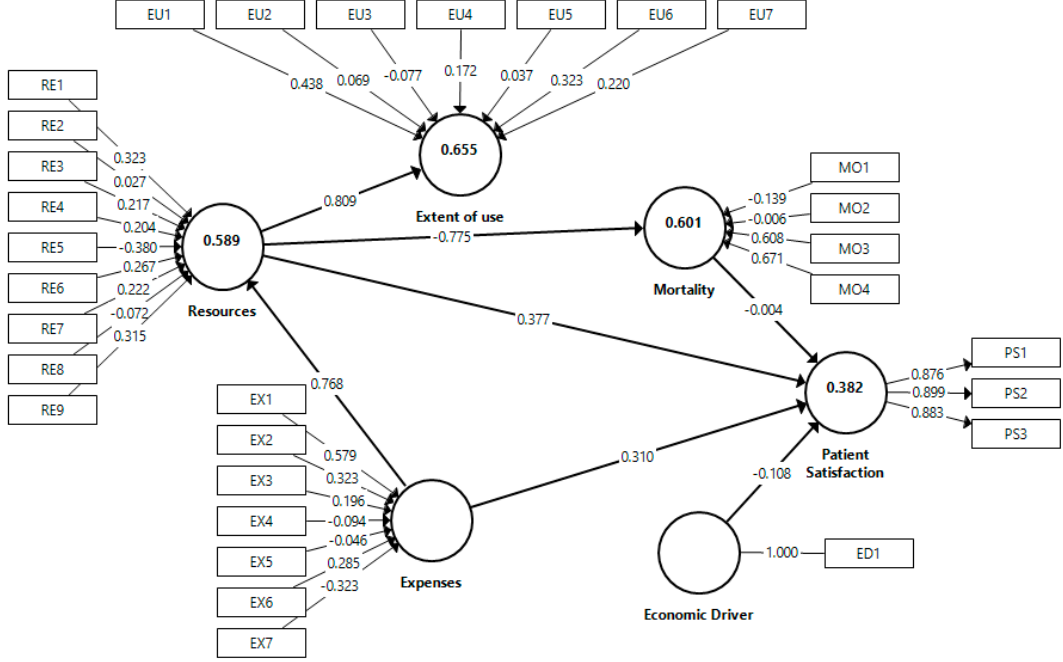
Figure 3. Whole model results for women.